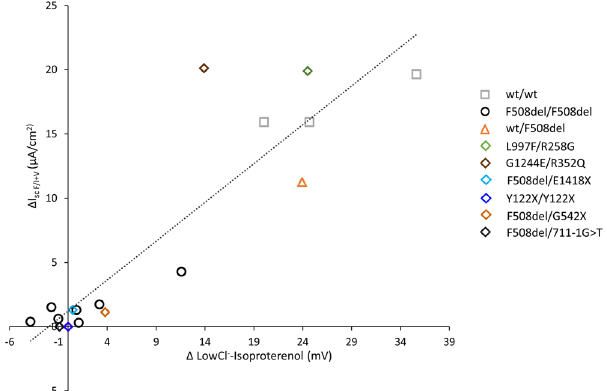
Figure 3. Correlation between CFTR activity evaluation in nasal cells in vivo and in vitro according to genotype. CFTR activity in vivo was expressed as the modification of the transepithelial potential difference in response to the sequential perfusion of the nasal mucosa to low Cl − solution and the further addition of Isoproterenol 10 µ M ( ∆ LowCl − Isoproterenol). CFTR activity in vitro was expressed as the I sc response to Forskolin (10 µ M)/IBMX (100 µ M) + VX-770 (10 µ M) ( ∆ I scF/I + V ). Data from 3 wt/wt control subjects, 1 wt/ F508del heterozygote, 7 F508del/F508del, and 6 patients with other genotypes (legend in the figure). The dotted line shows simple regression analysis of the data ( R 2 = 0.82, p <